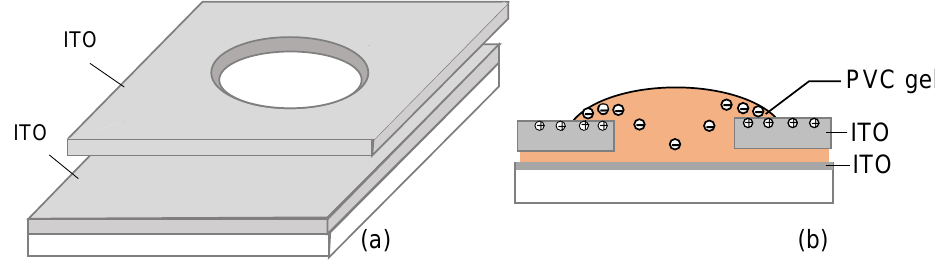
Figure 8. Device structure of a circular PVC lens: ( a ) structure of the electrode and ( b ) the operation mechanisms.